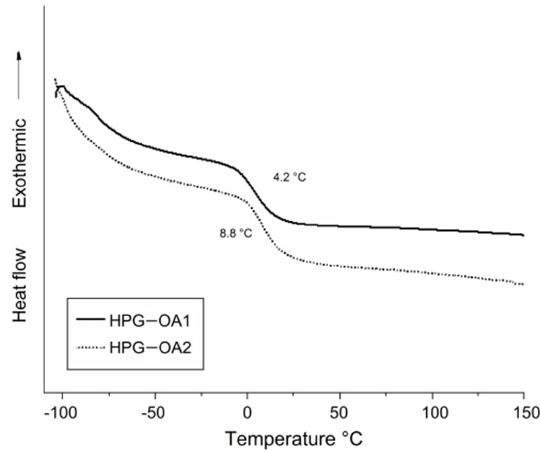
Figure 5. DSC thermograms of HPG-OA1 and HPG-OA2.